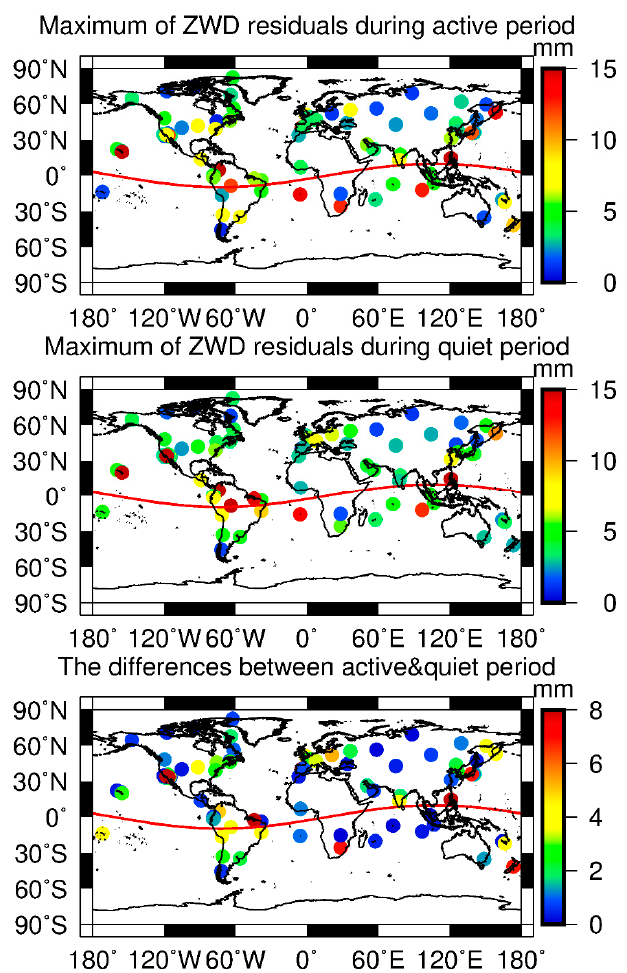
Figure 9. The maximum influences of HOI on ZWD estimates during active ( top ) and quiet ( middle ) periods as well as their differences (bottom) for stations located in different areas. (Active period: DOY 250–252 in 2017, quiet period: DOY 241–243 in 2017).